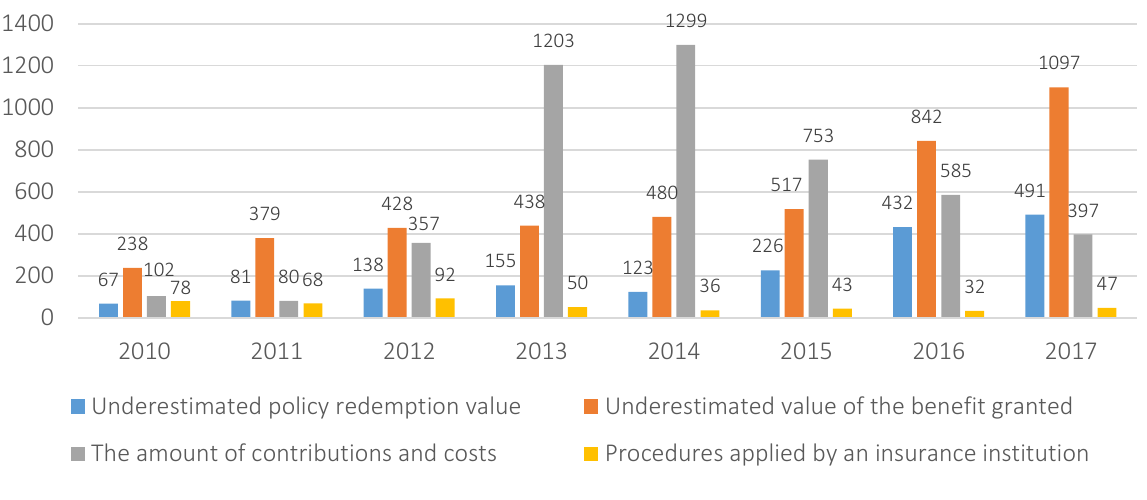
Figure 4. Number of complaints about construction elements of life insurance